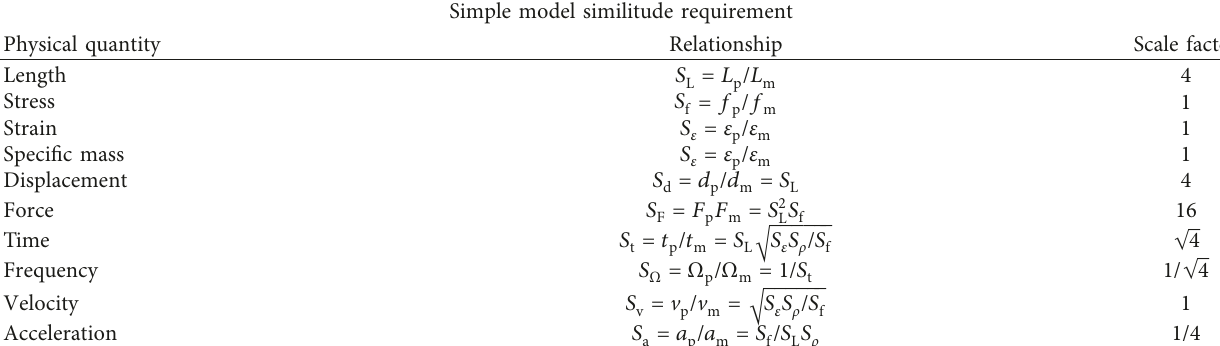
Table 3: Model-to-prototype quantity conversion